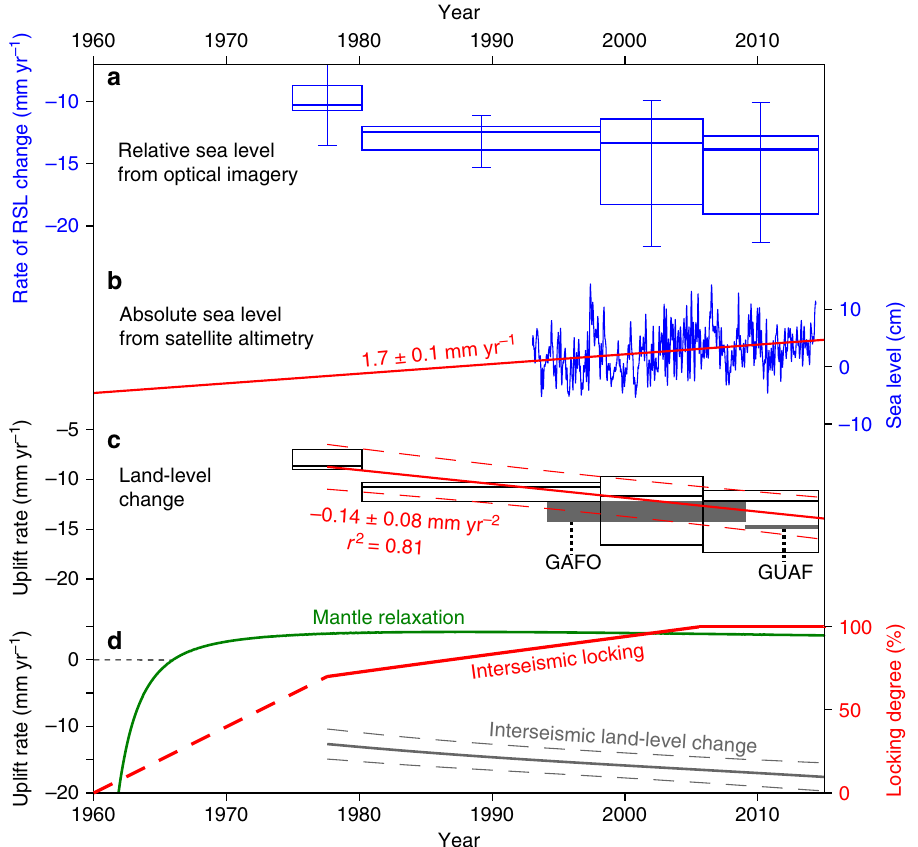
Fig. 5 Measured and estimated relative sea-level (RSL) and land-level changes at Guafo after the 1960 earthquake. a Box-and-whisker plots (center line, median; box limits, upper and lower quartiles; whiskers, 5th and 95th percentiles) showing RSL rise estimated from images in Fig. 2 (Supplementary Fig. 7). b Absolute sea level at Guafo from 1992 to 2015 multimission satellite altimetry obtained from AVISO site (French national space agency). Red line shows linear rate. c Land-level changes estimated by subtracting relative from absolute sea levels. Red lines show linear acceleration with 2 σ range, estimated from images and uplift rates from labeled GPS stations. d History of interseismic plate locking. Green line shows uplift rate at Guafo from viscoelastic mantle relaxation model (Methods); gray line shows rate inferred from interseismic locking obtained by subtracting mantle relaxation from land-level change. Solid red line shows locking rate expressed as fraction of plate convergence, estimated using up- and downdip limits at depths of 5 and 35 km, respectively (Methods, Fig. 4). Stippled red line shows inferred interseismic locking between 1960 and our earliest imagery measurements. The line has been truncated at the full plate locking rate after